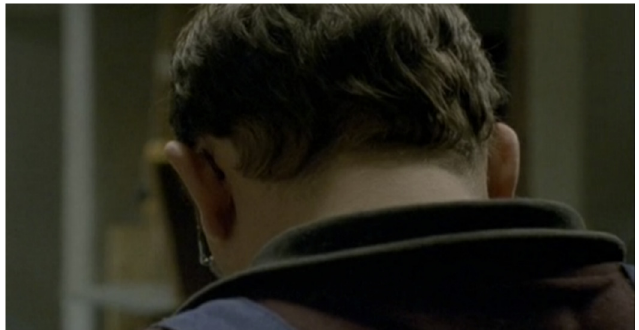
Figure 1. Opening Sequence of Le Fils .